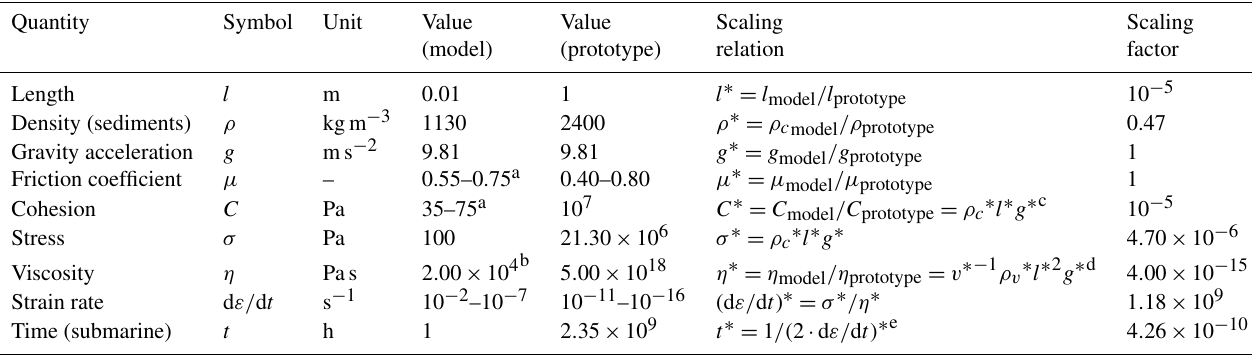
Table 1. Material properties and scaling relationship of the experiments in this study. Note the geometric scaling of 1cm in the model is 1km in nature, and time scaling of 1h in the model is 0.268Ma in nature.